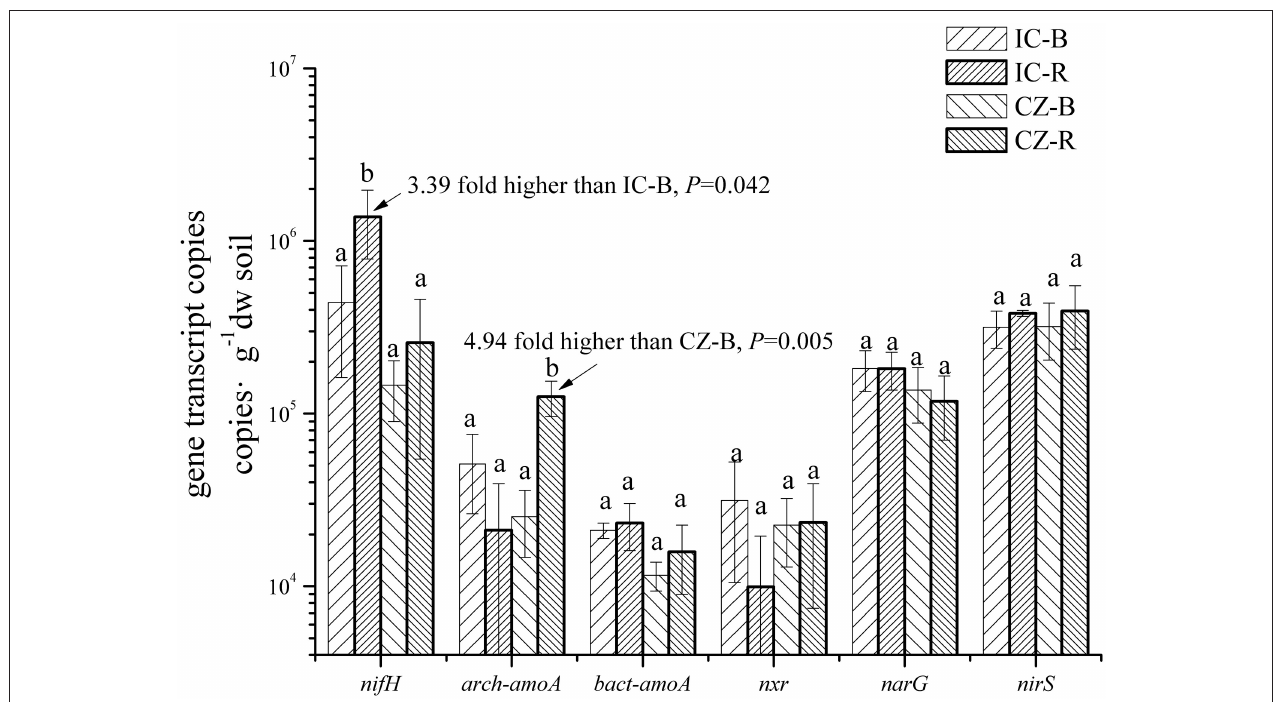
FIGURE 2 | Transcript abundances of genes involved in nitrogen cycling in the rhizosphere and bulk soil of I. cylindrica and C. zizanioides . Different letters indicate significant differences in each gene of samples (LSD, P < 0.05). Samples were bulk talings of I. cylindrica (IC-B), rhizosphere samples of I. cylindrica (IC-R), bulk tailings of C. zizanioides (CZ-B), and rhizosphere samples of C. zizanioides